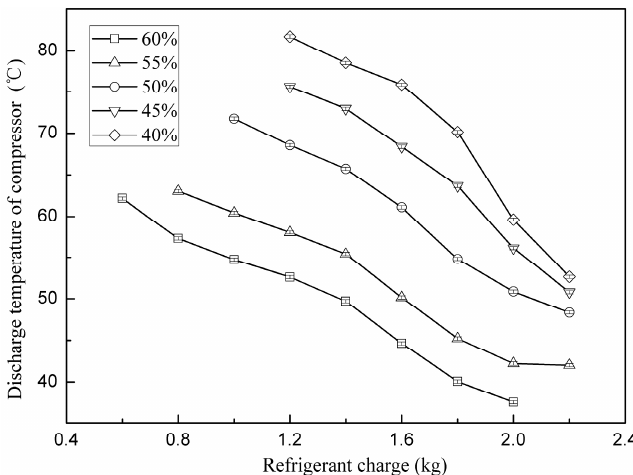
Figure 3. Variations of discharge temperature with refrigerant charge and EEV opening.